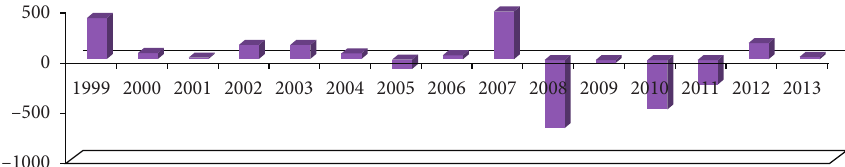
Figure 3: Annual rainfall deviations in the Bawku Municipality